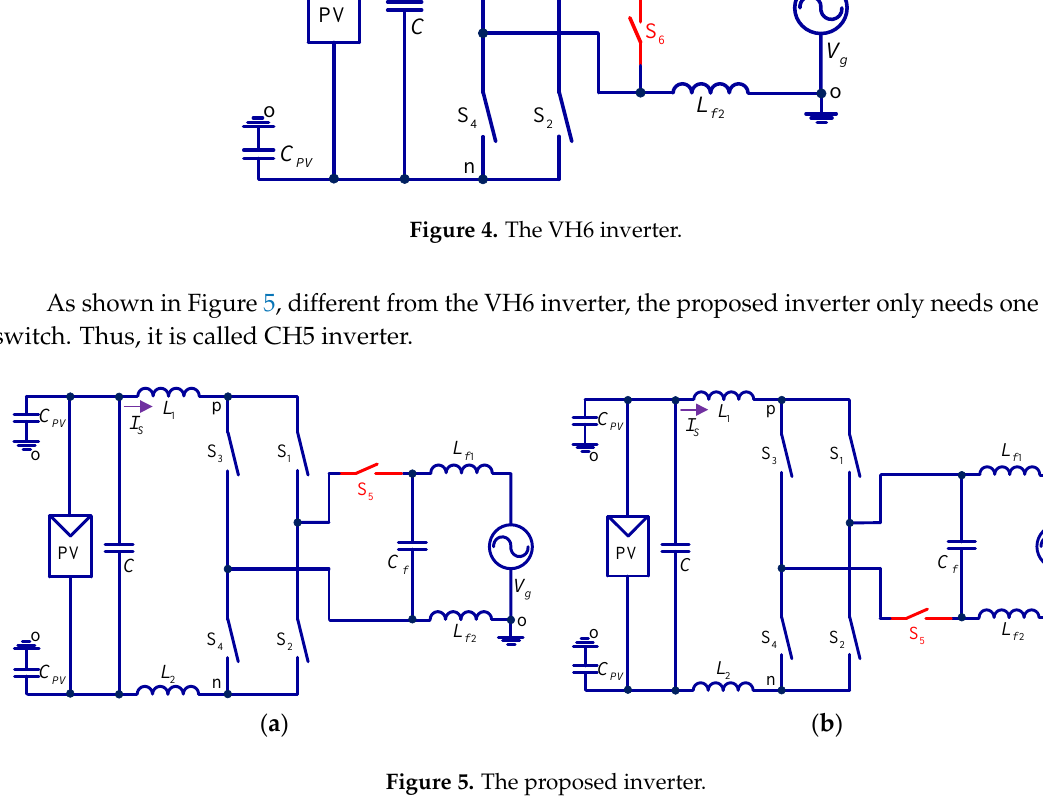
Figure 5. The proposed inverter.